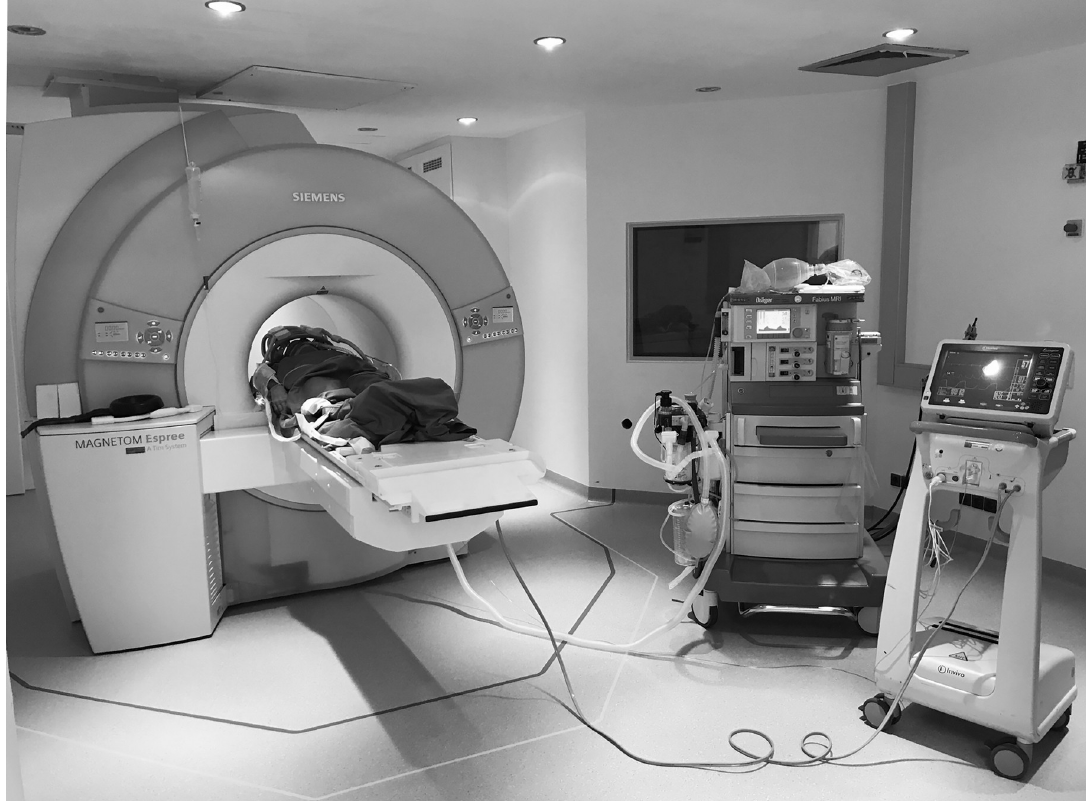
Fig 2. Setup of anesthesia equipment in the iMRI scanner. The MR-capable ventilator (Dra¨ger Fabius MRI, Dra¨gerwerke, Lu¨beck, Germany) is positioned outside the 30 mT area (dark line) while the monitoring hardware has to be kept outside the 20 mT area (light yellow